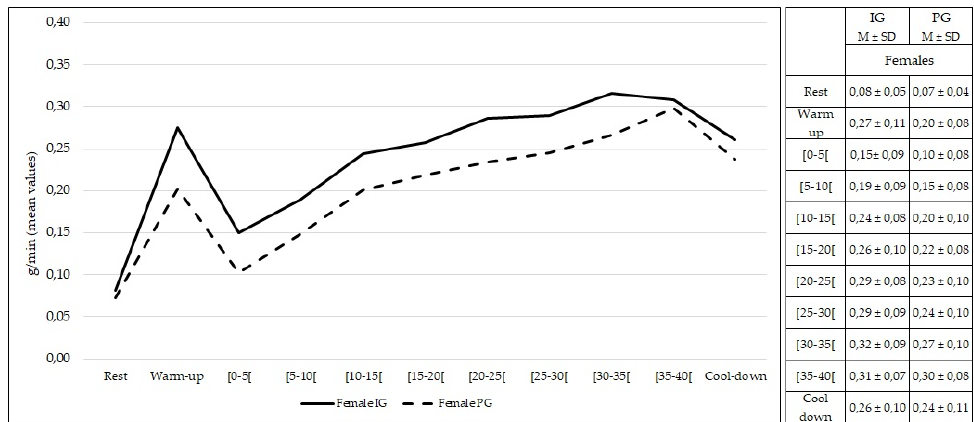
Figure 5. Lipid oxidation during rest, exercise, and cool-down in females (intervention group vs. placebo group). Data are expressed as mean ± standard deviation. IG: intervention group; PG: placebo group.